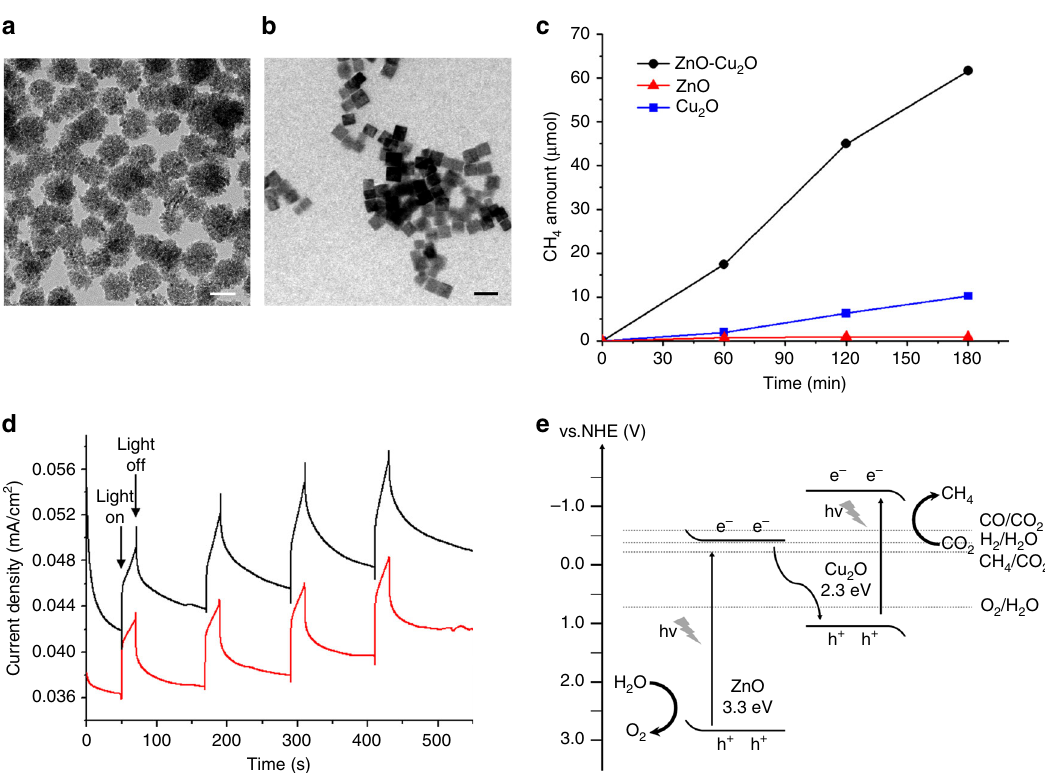
Fig. 3 Control experiments with the ZnO and Cu 2 O nanoparticles and mechanistic study of the ZnO-Cu 2 O catalysts. TEM images of a ZnO spheres and b Cu 2 O nanocubes. The scale bars represent 50 nm. c Amount of CH 4 production using ZnO-Cu 2 O (black) catalysts, and ZnO (red) and Cu 2 O (blue) nanoparticles under the conditions with catalyst amount fi xed to 19 mg, pH = 7.4, and λ > 200 nm. d Photoresponse data of the ZnO-Cu 2 O catalyst deposited on a FTO electrode at a potential of − 0.45 V vs. Ag/AgCl in a phosphate buffer by the irradiation of UV – visible (black) and visible (red) light using a cutoff fi lter ( λ > 425 nm). e Band alignment and proposed electron transfer mechanism of the ZnO-Cu 2 O hybrid